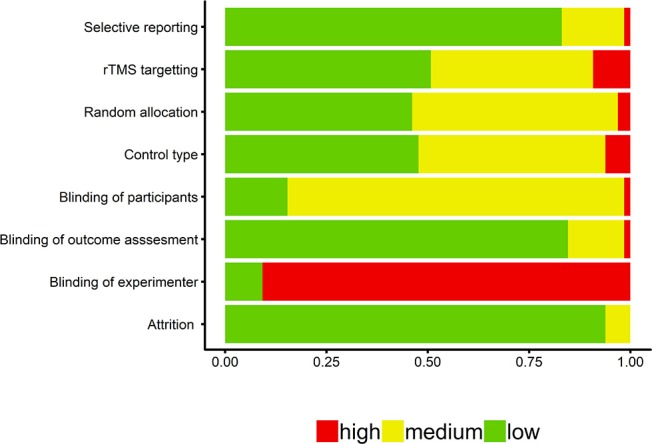
Quality assessment findings for the 59 articles included in the systematic review. Blinding of outcome assessment reflects blinding of the experimenter in coding memory outcome measures (e.g., recall tasks).